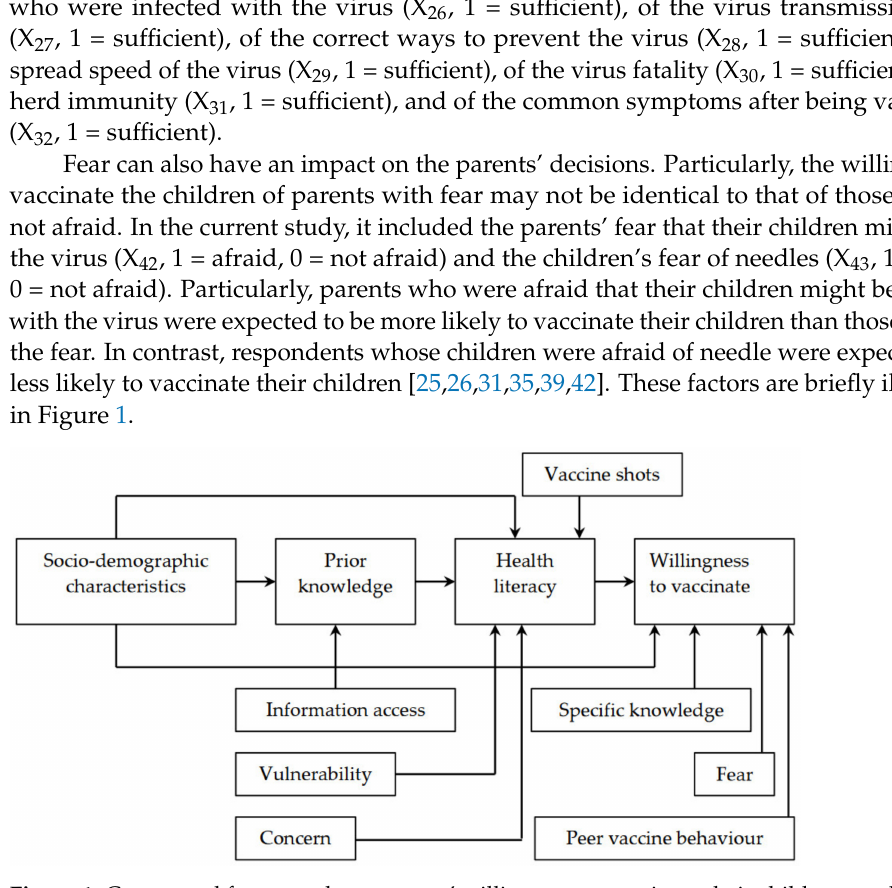
Figure 1. Conceptual framework on parents’ willingness to vaccinate their children aged from 5 to under 12 years. Source. Illustrated by the authors with ideas adapted from Sun et al.